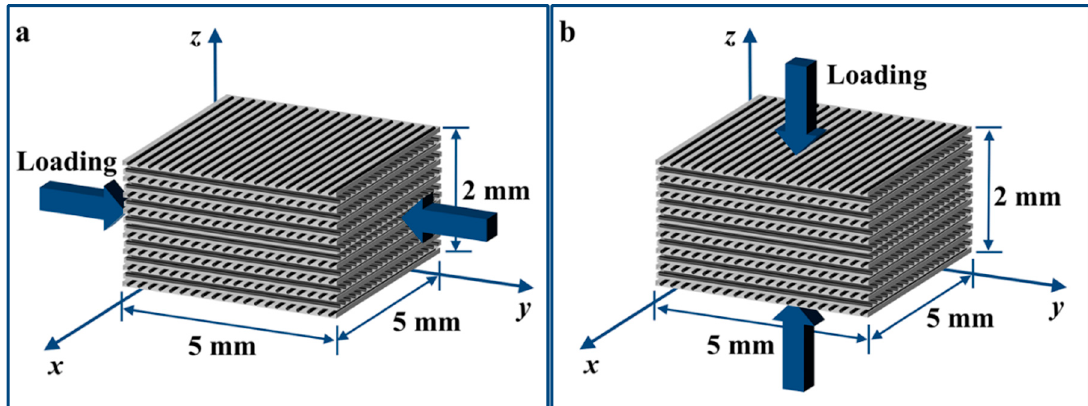
Figure 1. Two typical loading directions in the compression test for block AS4/PEEK composite laminates specimens with a stacking sequence of (0 ° /90 °) 4s . ( a ) In-plane loading. ( b ) Out-of-plane loading. Table 1. Loading strain rates and detailed specifications of AS4/PEEK composite laminates specimens.